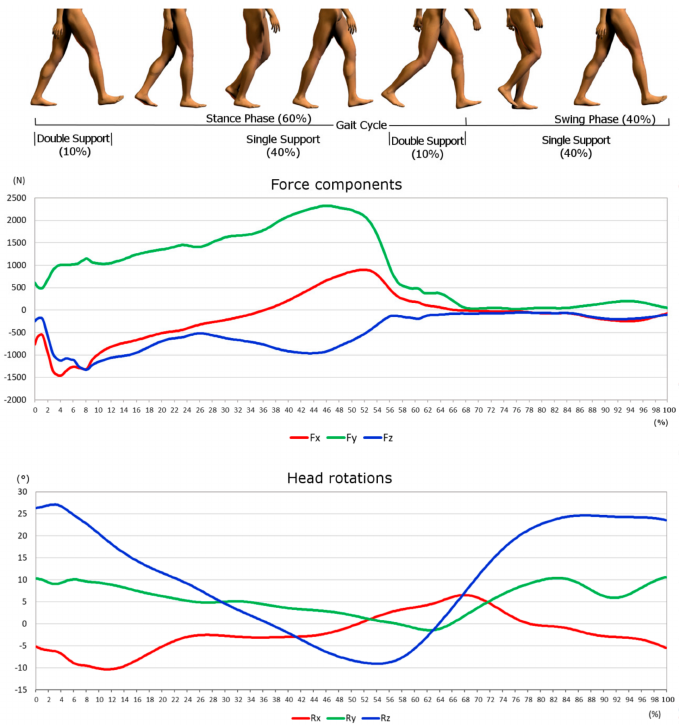
Figure 4. Forces components, in red Fx, in green Fy, in blue Fz. Head rotations, around x axes in red, y axes green and z axes blue.